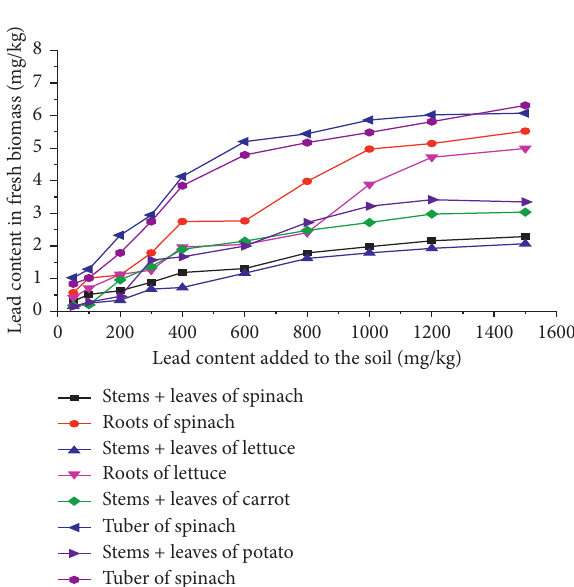
Figure 1: Lead concentrations in the soil and in the biomass of the studied vegetables grown in this